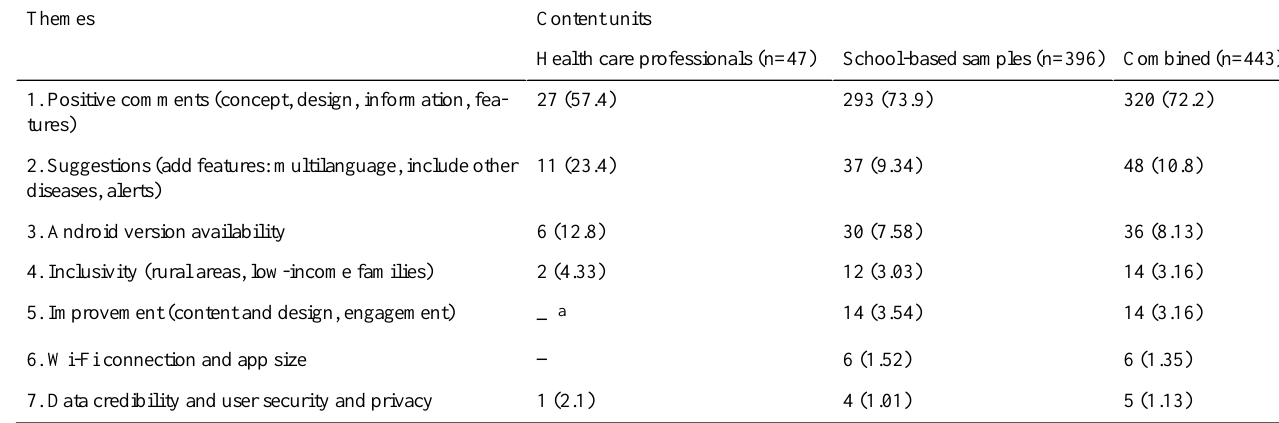
Table 4. The major themes that emerged from individual interviews and focus group discussions among health care professionals and school-based